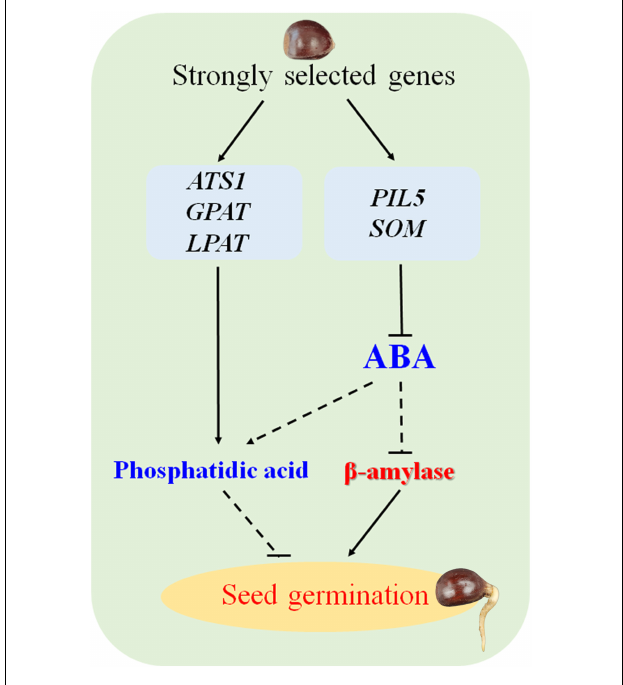
FIGURE 6 | Model of the seed germination mechanism regulated by strongly selected genes in Chinese